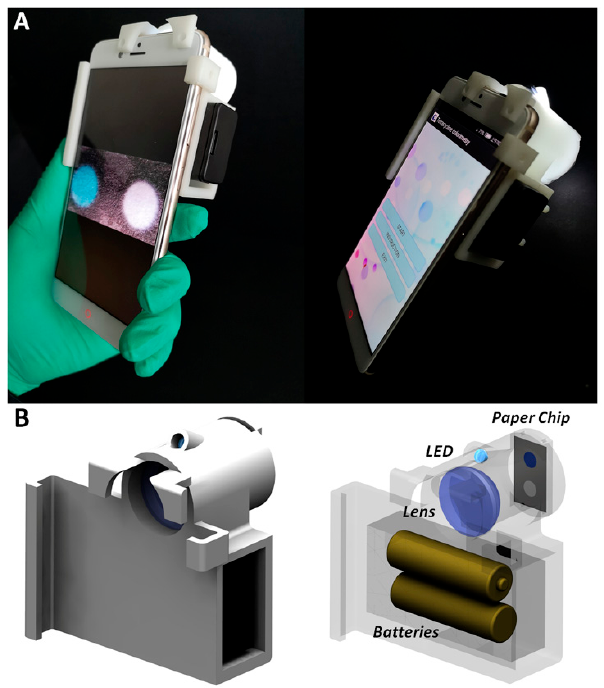
Figure 2. Smartphone based paper chip reader. ( A ) System photo. ( B ) Optical design.